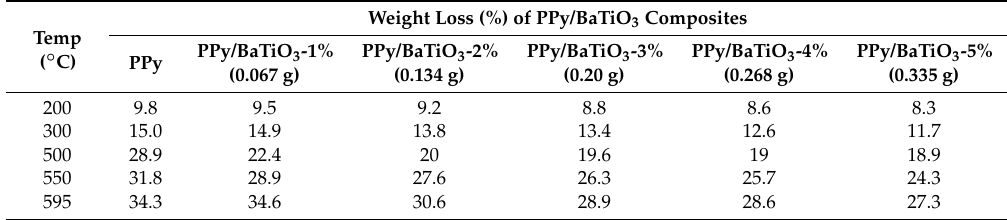
Table 3. Weight loss data from TGA analysis of PPy/BaTiO 3 composites at various temperatures.